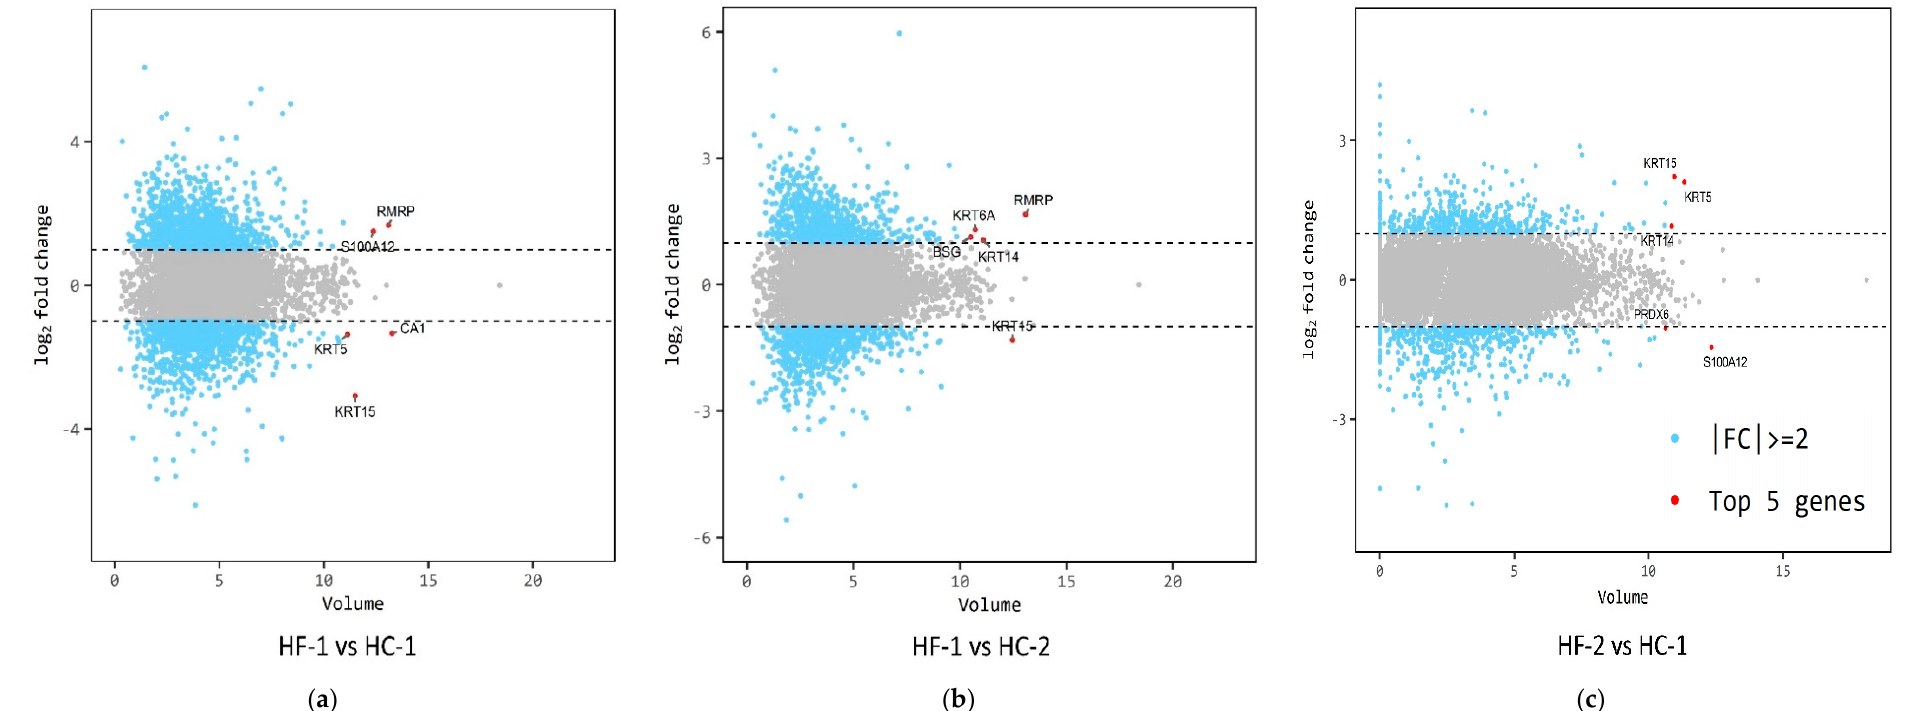
Figure 6. Gene expression volume plot between treatment groups. Genes that showed higher expression difference between HF-1 (control group) and HC-1 (treated group) ( a ). Genes that showed higher expression difference between HF-1 (control group) and HC-2 (treated group) ( b ). HF-2 (control group) and HC-1 (treated group) ( c ). RMRP, RNA component of mitochondrial RNA processing endoribonuclease; S100A12, S100 calcium binding protein A12; CA1, carbonic anhydrase I; KRT5, keratin 5; KRT6A, keratin 6A; KRT14, keratin 14; KRT15, keratin 15; BSG, basigin; PRDX6, peroxiredoxin 6. Red dot: top 5 genes by volume which satisfies, |fc| ≥ 2. FC, fold-change.